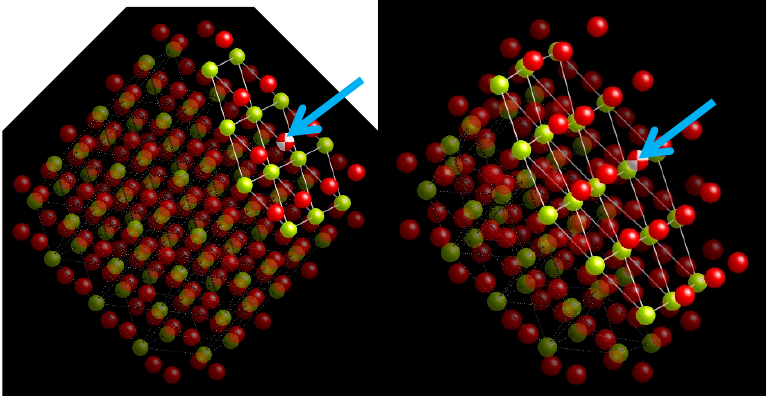
Figure 1. Creation of a surface oxygen vacancy (shown by a cyan arrows) that subsequently migrates to the crystal interior where it is energetically more stable (Personal communication, Professor Alastair Cormack, Alfred University, Alfred, New York).